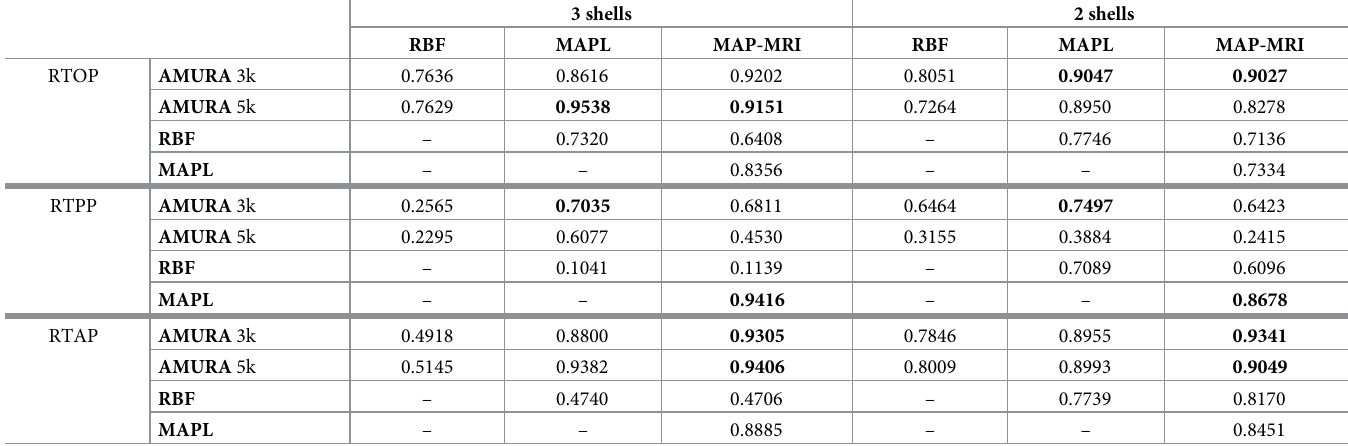
Table 3. Correlation coefficients between the different methods to estimate RTOP, RTPP and RTAP. The higher the better. AMURA are computed from one single shell at either b = 3,000s/mm 2 (3k) or b = 5,000s/mm 2 (5k). Multi-shell methods are always compared between them with the same number of shells (2 or